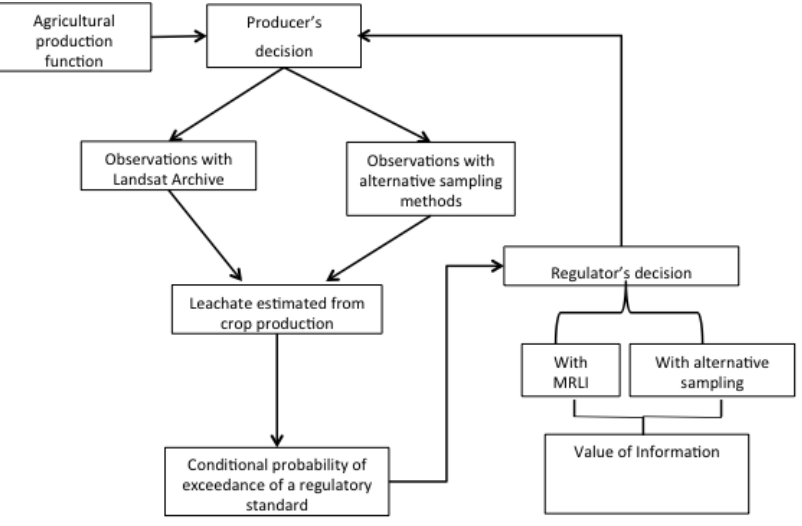
Figure 3. Conceptual framework for producer and regulator choices for estimating the monetized benefits of moderate resolution land imagery (MRLI) (source: [16])